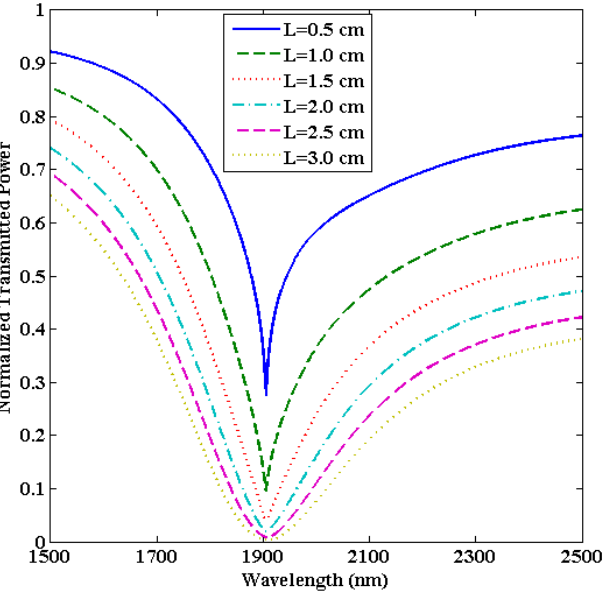
Figure 7. Transmitted LMR spectra (only the first LMR curve) for various sensing region lengths (L) of an ITO-coated U-shaped fiber optic LMR sensor. Here, SMRI = 1.33, d = 90 nm, and R = 1.0 cm. For L = 0.5 cm, a sharp LMR curve is attained at resonance wavelength 1906 nm,